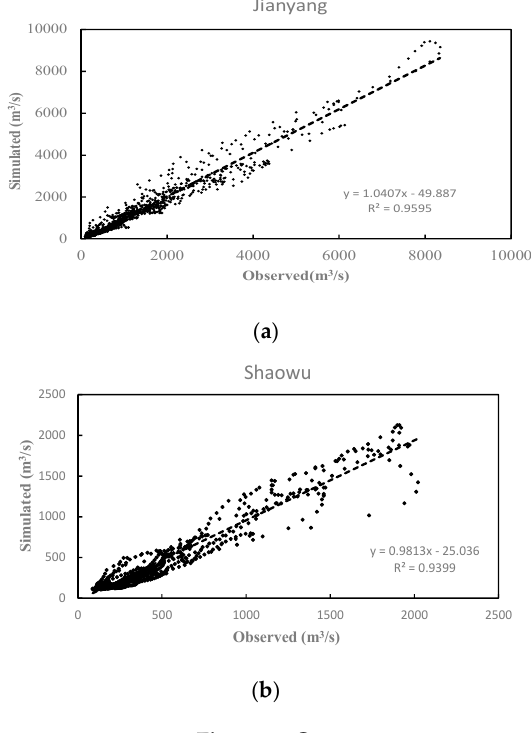
Shuiji Figure 6. Cont